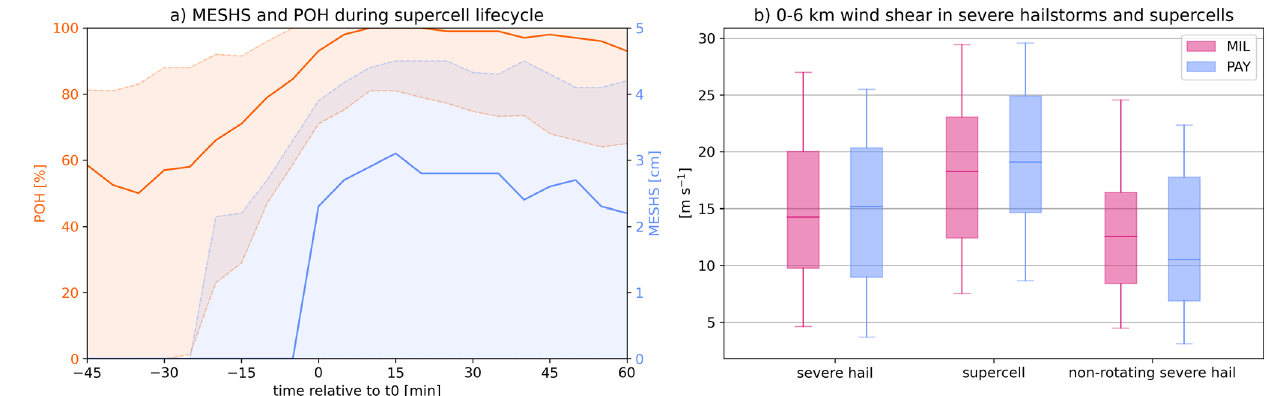
Fig. 5 Evaluating the temporal relationship between mesocyclone onset and hail. a Behaviour of POH and MESHS during SC life cycle; b deep-layer bulk shear from radiosoundings in Milano (MIL) and Payerne